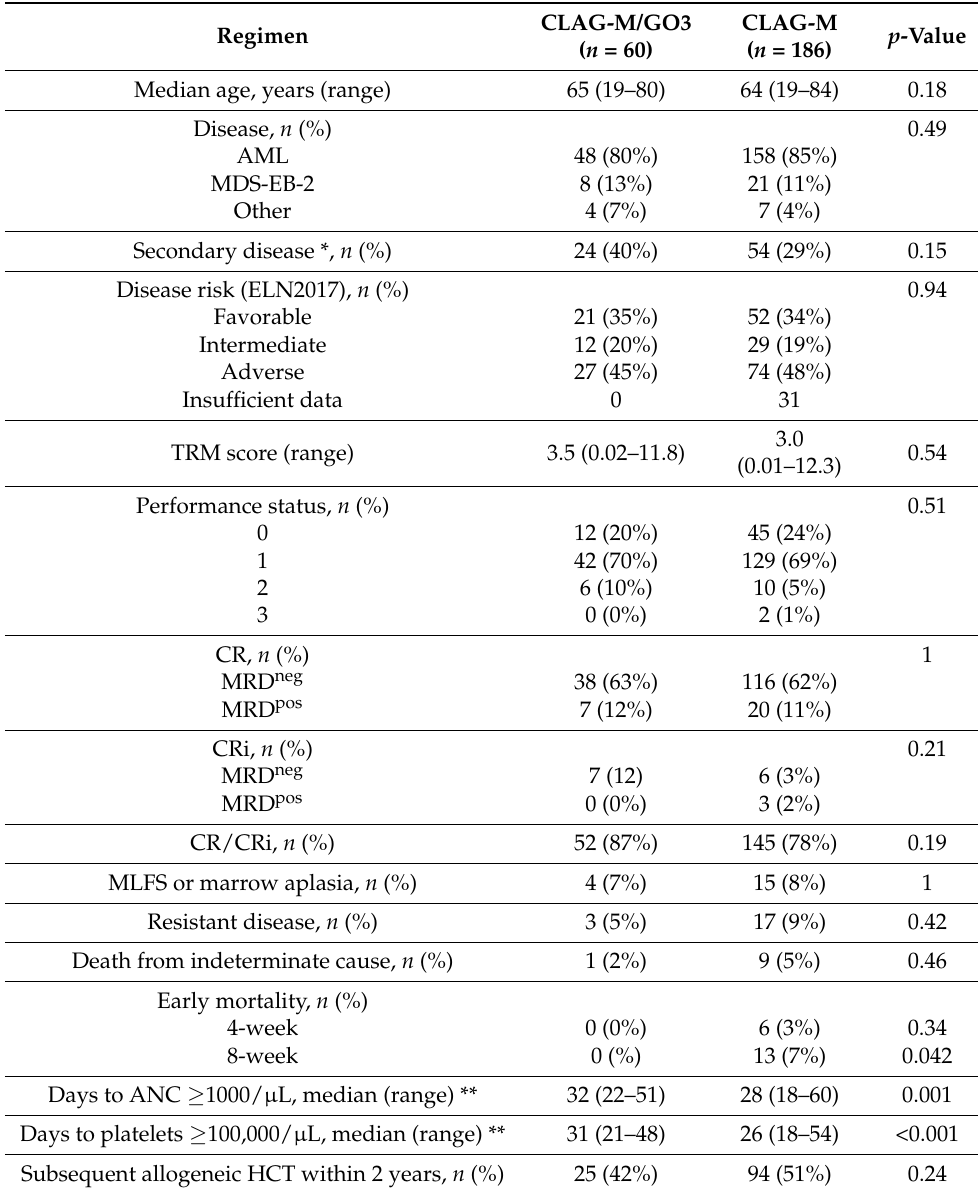
Table 6. Comparison of CLAG-M/GO3 and CLAG-M